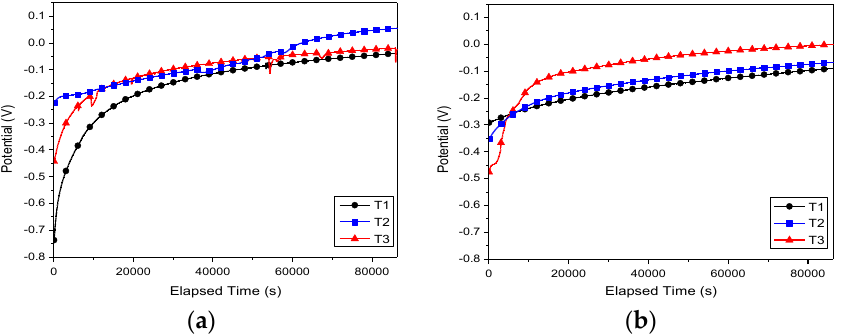
Figure 7. Open circuit potential vs. time curves of the investigated alloys in ( a ) SBF and